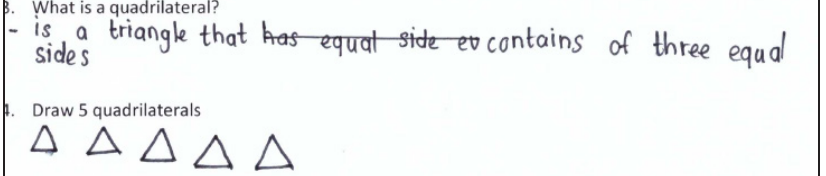
Figure 3: Students’ erroneous responses to the definition of a quadrilateral